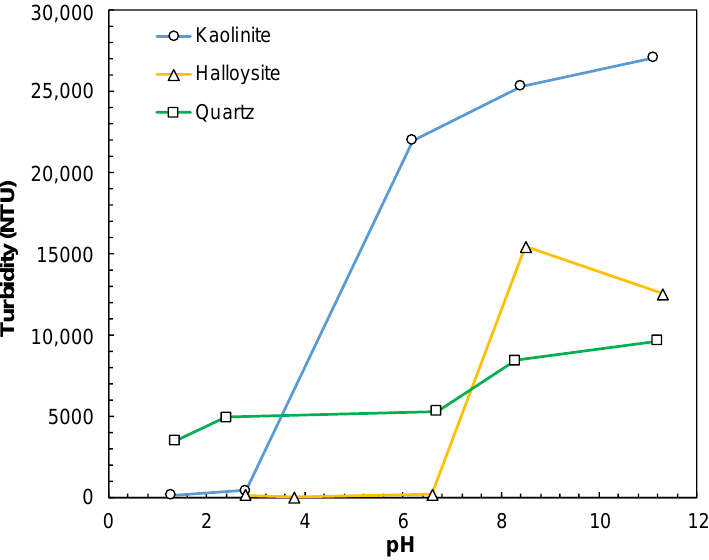
Figure 8. The change in turbidity values of halloysite, kaolinite, and quartz minerals measured at different pH values after 120 min sedimentation period.